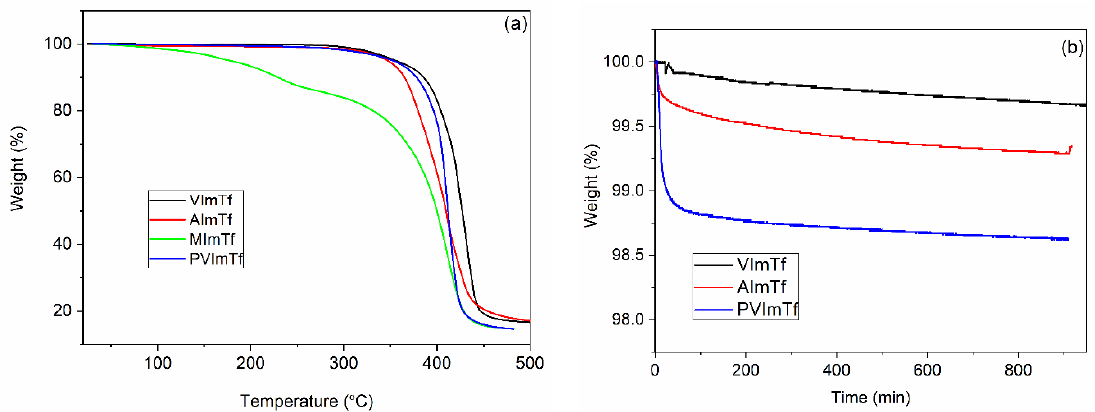
Figure 1. ( a ) TGA curves and ( b ) TGA isotherms at 130 °C for synthesized PILs.